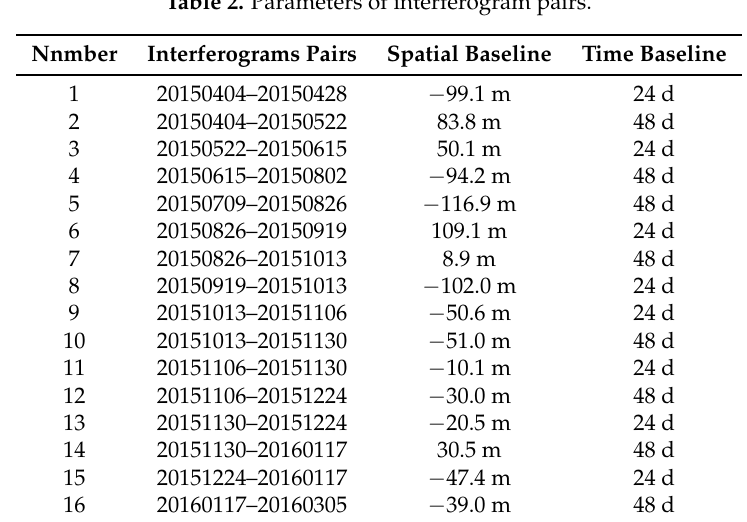
Table 2. Parameters of interferogram pairs.